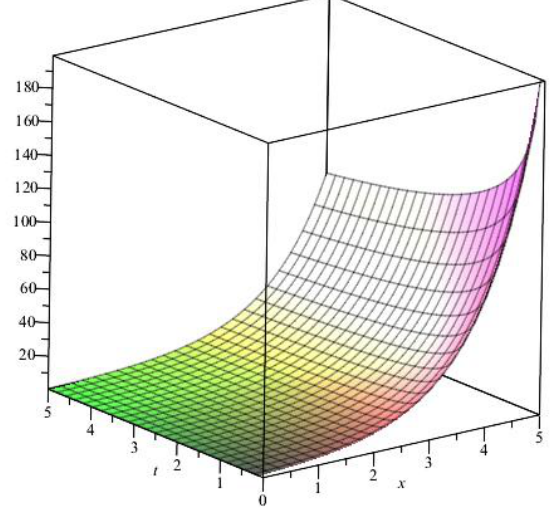
Figure 1: Values of the options for α = ρ = 1 Figure 1. Values of the options for α = ρ = 1.